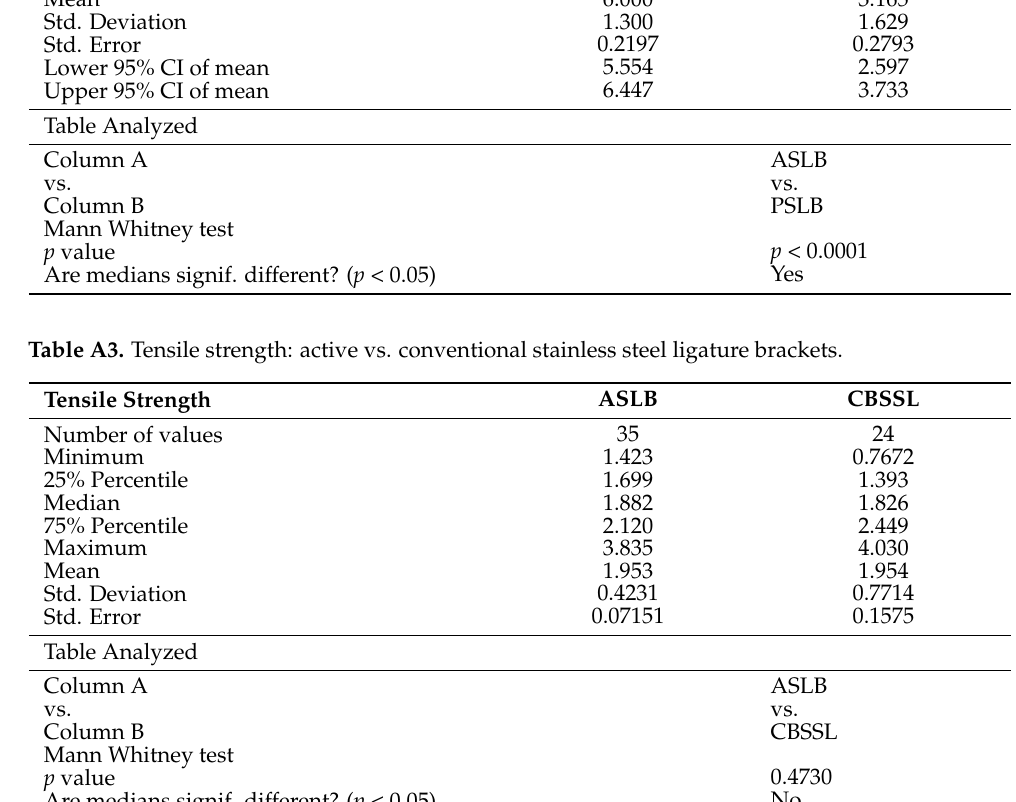
Column A ASLB vs.